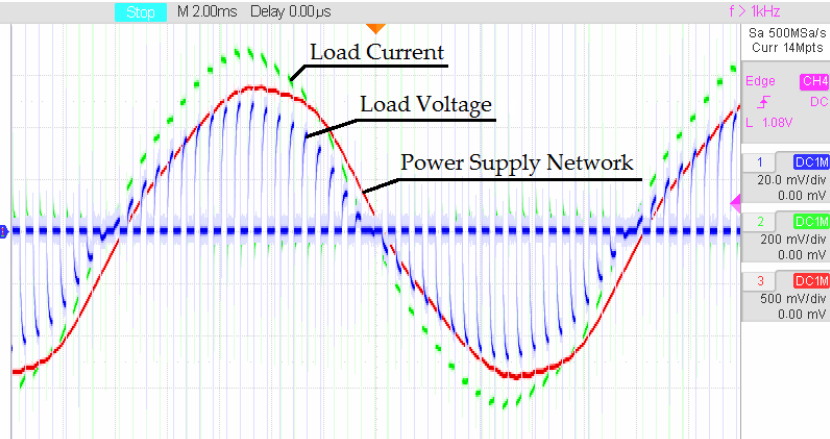
Figure 23. Oscillograms of load voltage and current under active load.